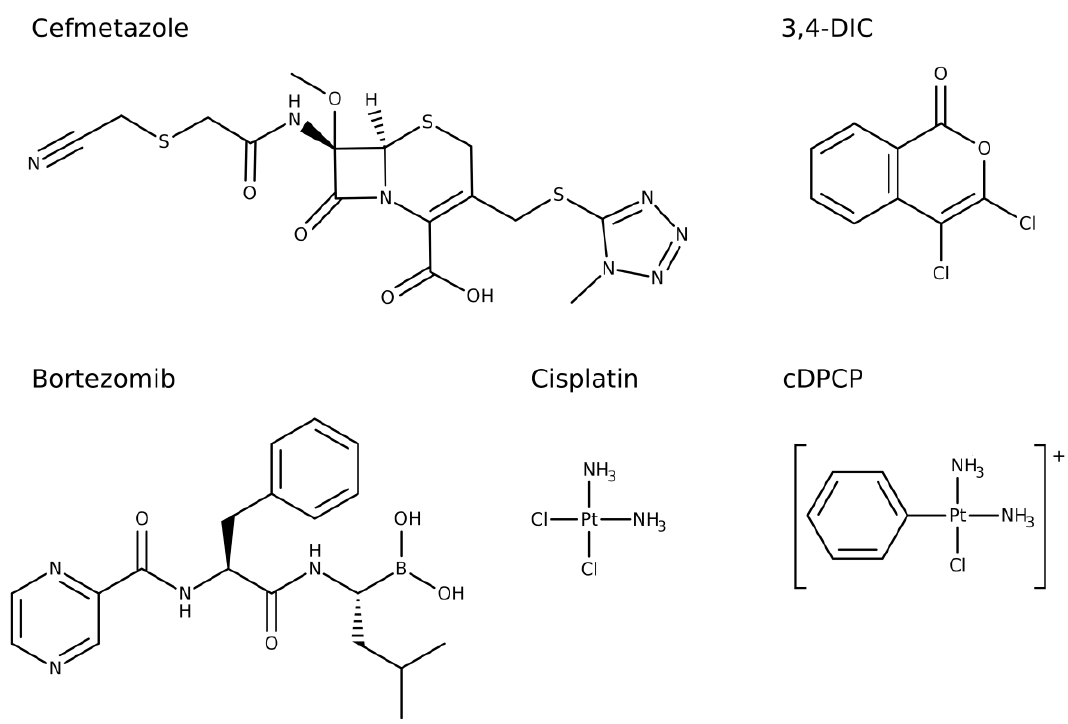
Figure 1. Structural formula of the five ClpP inhibitors identified in this study. 95